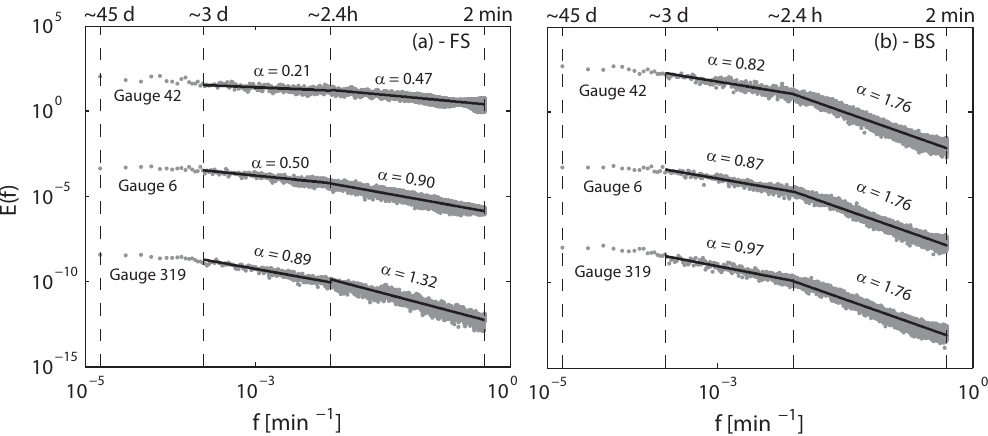
Fig. 3. Example of scaling regimes obtained through the spectral analysis for gauges with IDs 42, 6 and 319 (shown in Fig. 1b), for (a) the FS and (b) the BS series. The slopes of the lines are estimates of the spectral exponents α FS and α BS in Eq. (1). Arbitrary units on the y-axis are used in order to display results from different gauges in the same graph.